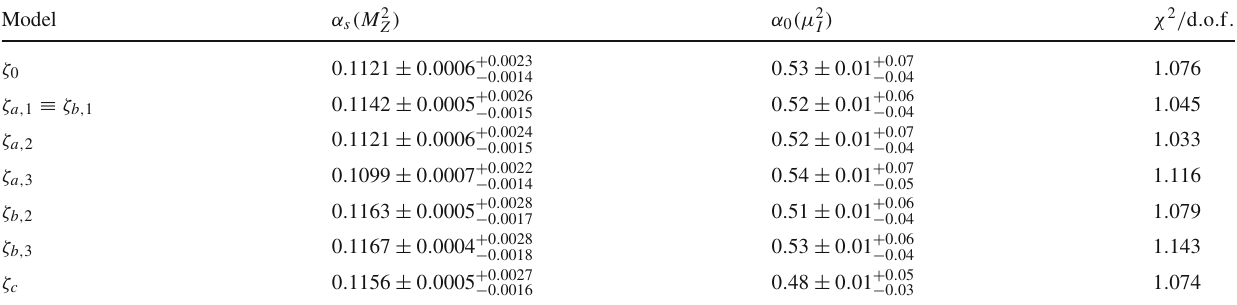
Table 2 Results of fits for α s and α 0 using the different functional forms for ζ( C ) reported in Eq. (21). The quoted uncertainties encode thetotal(statisticalandsystematic)experimentaluncertainty(firstnum- ber) and the total theoretical uncertainty (second number) estimated as Model α 0 (μ 2